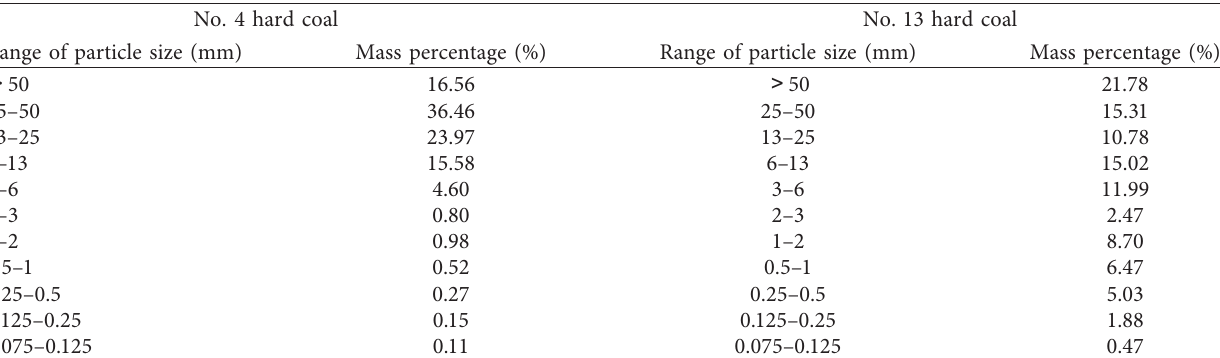
Figure 1: Macroscopic structures of the soft and hard coal in the different coal seams. (a) Hard coal of the No. 4 coal seam. (b) Soft coal in the No. 4 coal seam. (c) Hard coal of the No. 13 coal seam. (d) Soft coal in the No. 13 coal Table 1: Determination of the particle size distribution of the hard coal.